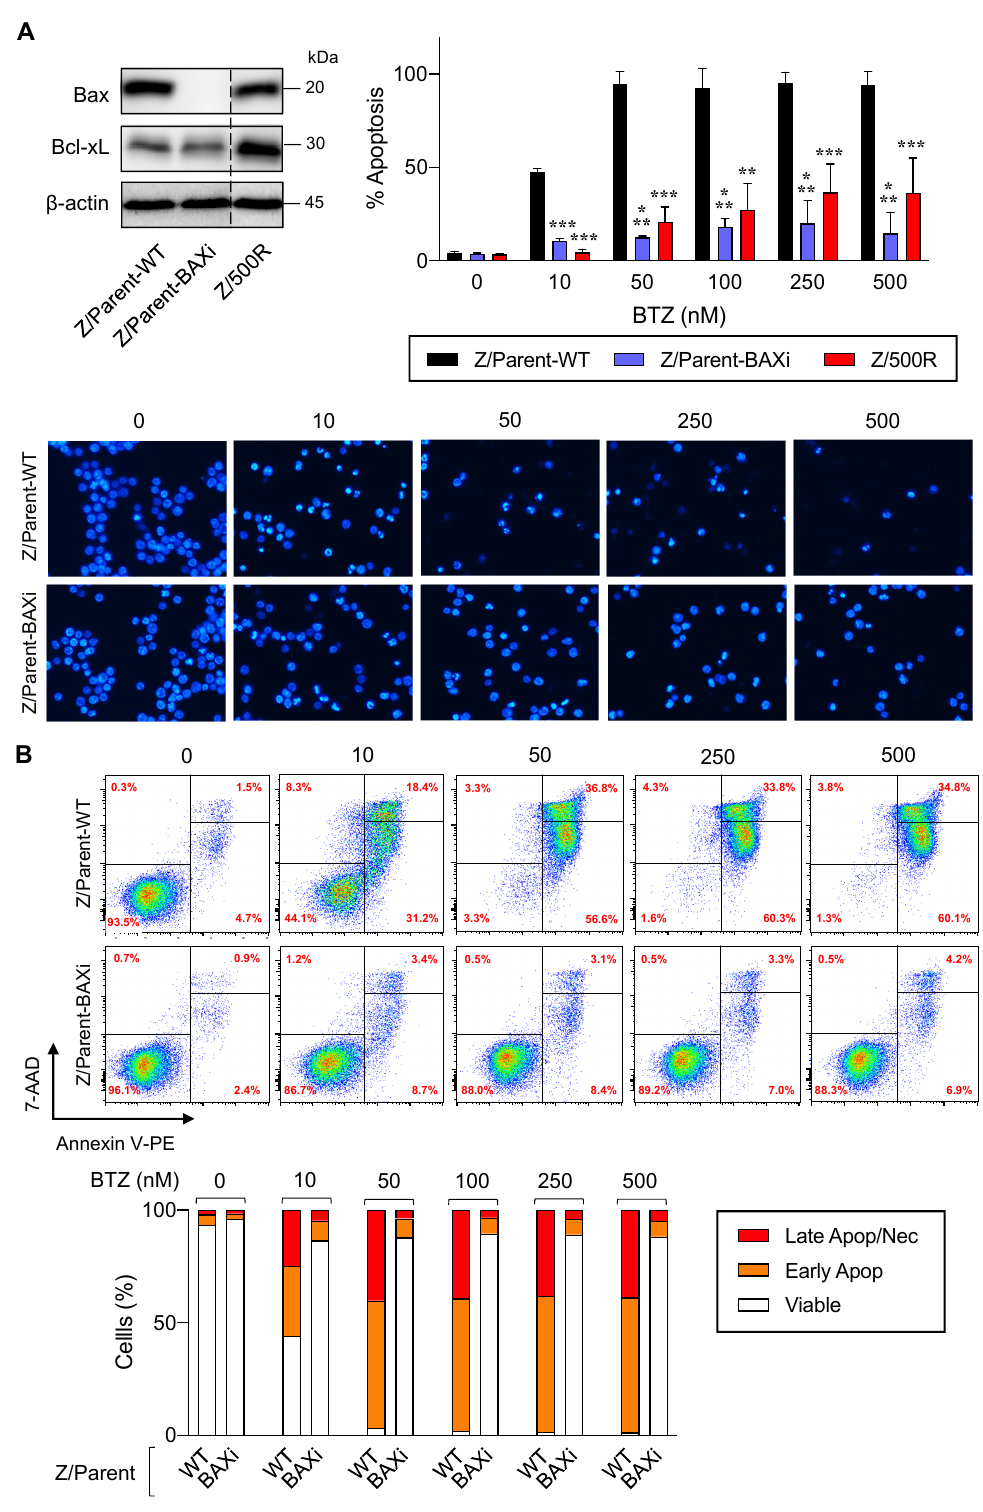
Figure 7. Bax is also a key mediator of BTZ-induced apoptosis. Parental Z/Parent cells were transduced with lentiviral particles carrying Cas9 and sgRNA against human BAX or control particles (WT) and treated with BTZ (0–500 nM) for 24 h. ( A ) Upper left : Western blot analysis of Bax level, along with Bcl-xL level, in Z/Parent-WT and Z/Parent-BAXi cells in comparison to the highly BTZ-resistant Z/500R cells prior to experiments. The dashed line separates juxtaposed lanes taken from the same experiment and blot image. Upper right : Percentages of apoptosis as evaluated by Hoechst 33342 assay were scored and plotted. Data are mean ± SD ( n = 3). ** p < 0.01, *** p < 0.001 versus Z/Parent-WT cells; two-sided Student’s t -test. Lower : Representative micrographs of Hoechst 33342 nuclear staining under an inverted fluorescence microscope. ( B ) Analysis of cell death by Annexin V/7-AAD assay. Percentages of Annexin V single-positive cells defining early apoptosis, and An- nexin V and 7-AAD double-positive cells defining late apoptosis/necrosis combined with 7-AAD single-positive cells defining necrosis were plotted.